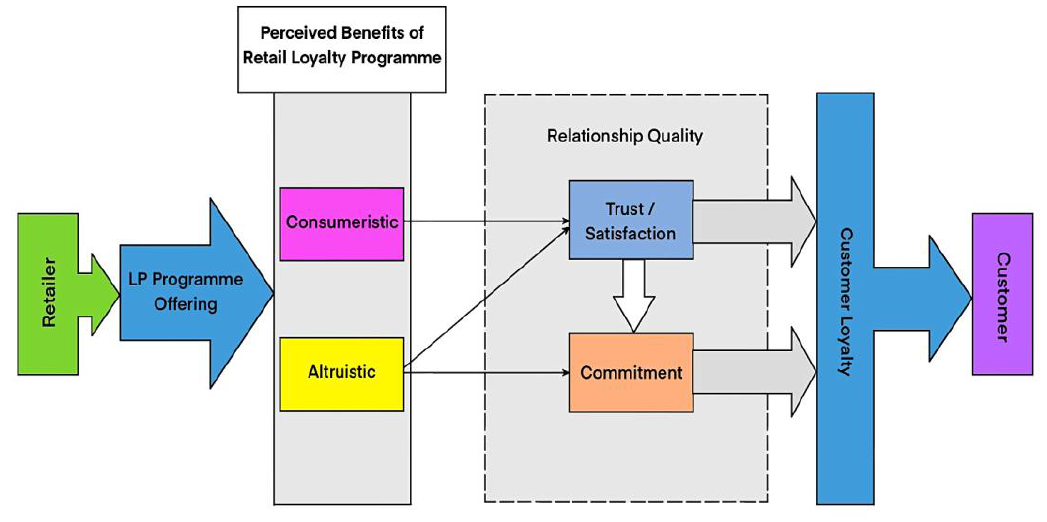
Figure 4: Model of Perceived Benefits of Lps and Customer-Retailer Relationship; Source :